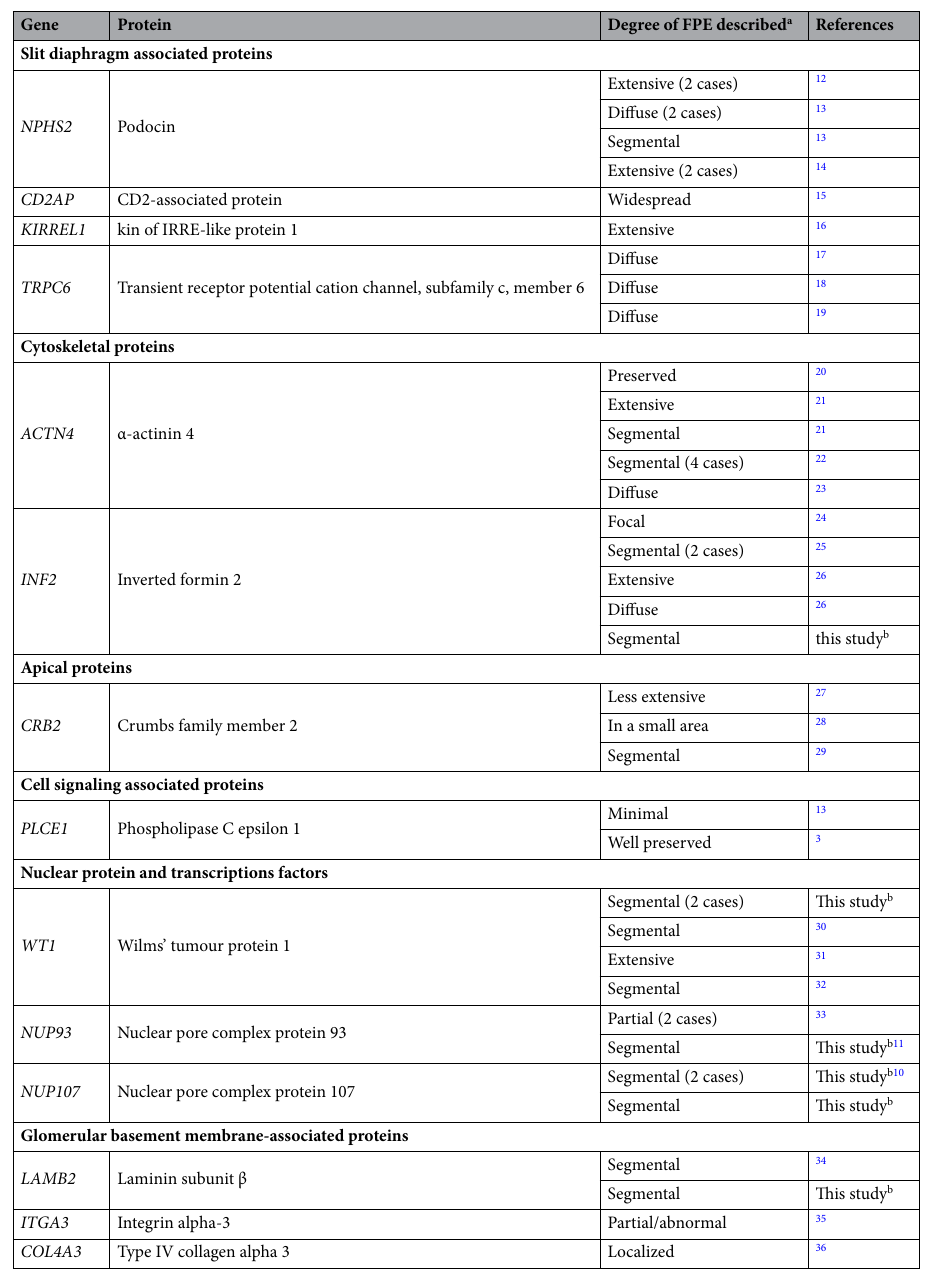
Table 2. Foot process effacement in genetic FSGS, as demonstrated in published literature and the present study. FPE, foot process effacement. a The degree of FPE was shown according to the description in each literature. b Patients included in this